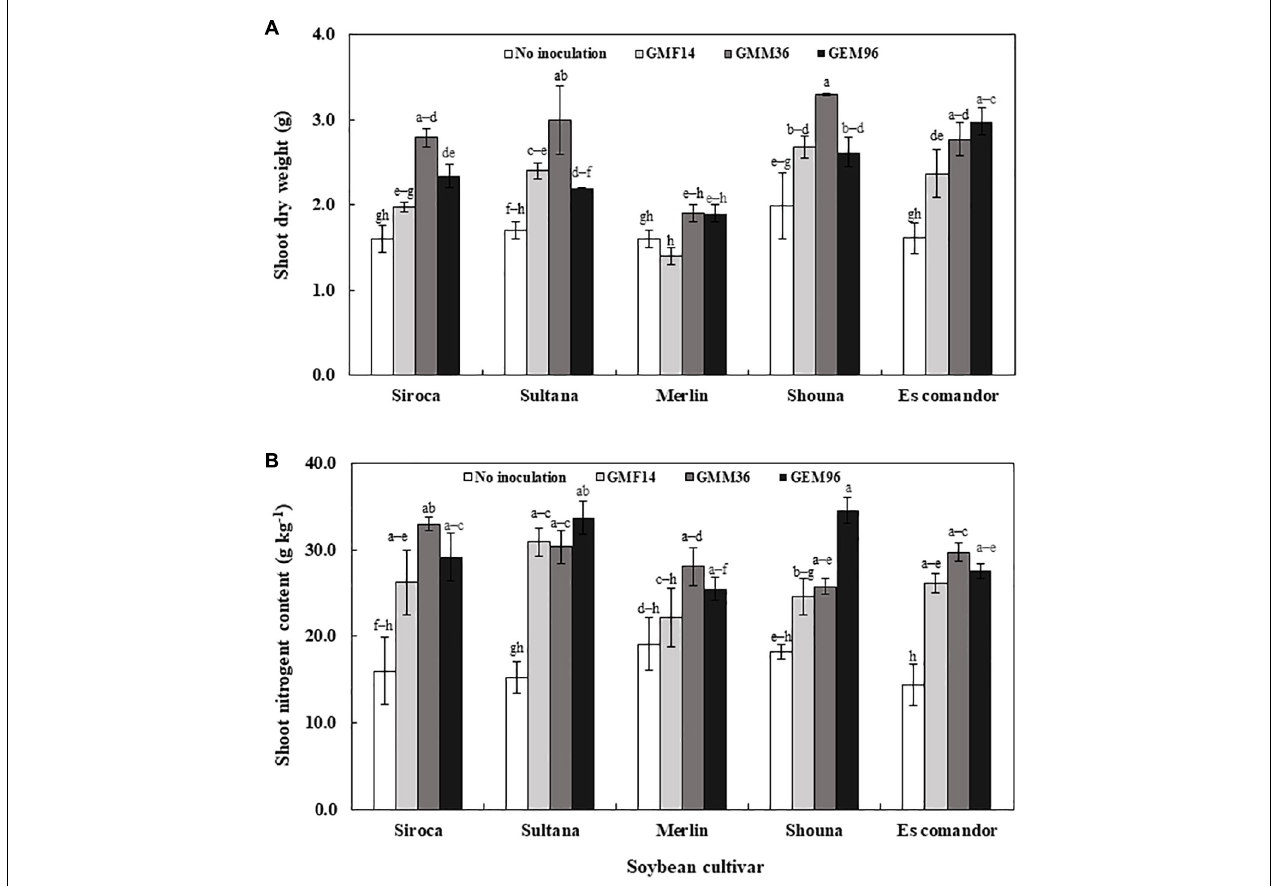
FIGURE 1 | Shoot dry weight (A) and shoot nitrogen content (B) following inoculation of different Bradyrhizobium strains to five soybean cultivars in the first greenhouse experiment. The error bars are standard deviation of three replications ( n = 3). Values followed by the same letters on each bar are not significantly different at p ≤